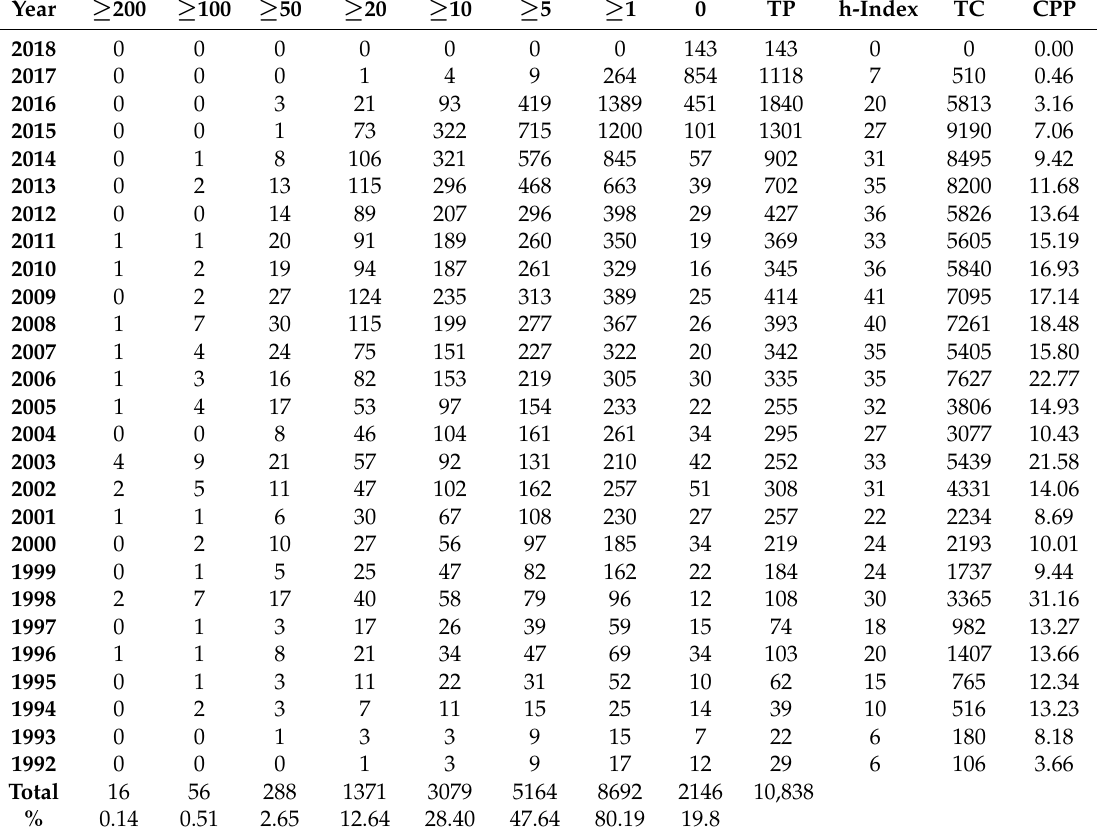
Table 1. General citation Structure in the Journal: NC